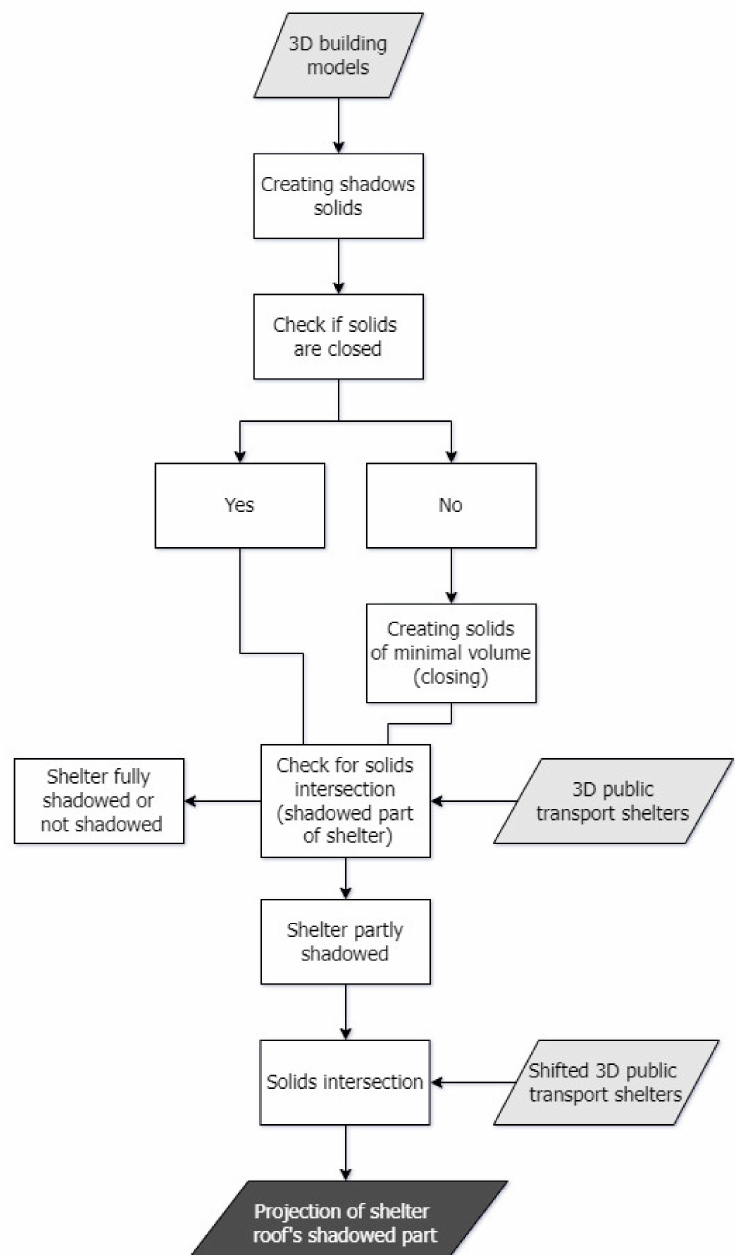
Figure 18. Workflow diagram for 3D shading spatial analysis. The shadows were generated for two selected days of the year: 22 June and 22 December. The calculations were made for the entire range of hours from sunrise to sunset. Figure 19 shows the shadows generated in June for buildings around the tram stop Rondo ONZ 04 at 10:30, while Figure 20 shows the shadows of buildings at the Dworzec Centralny 08 tram stop for the same day and